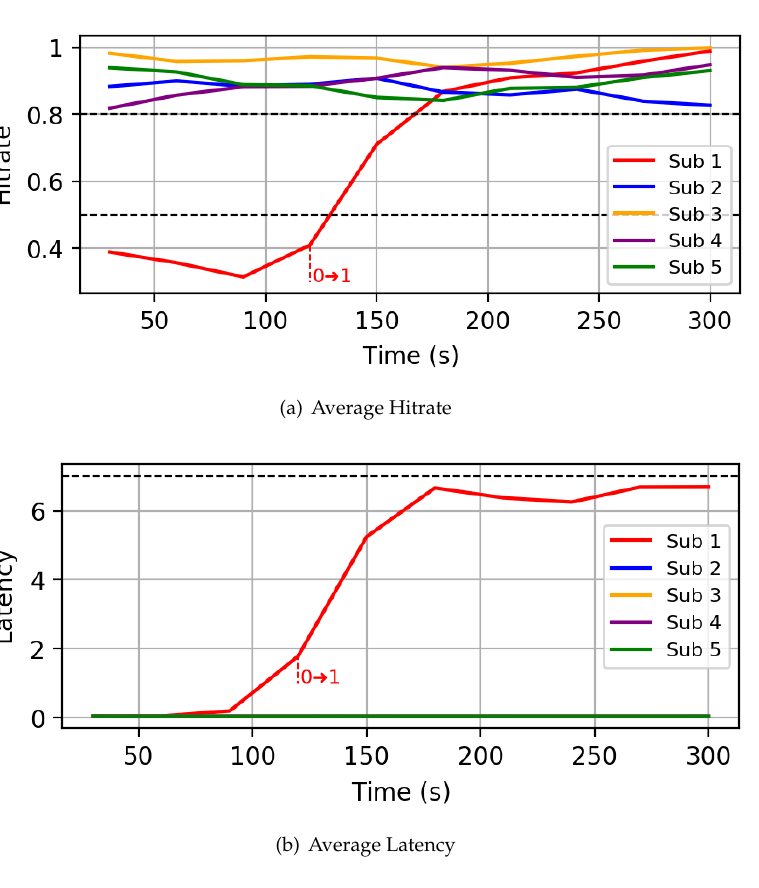
Figure 10. Autonomous mode scenario. The black dotted lines indicate the thresholds used during the simulation.